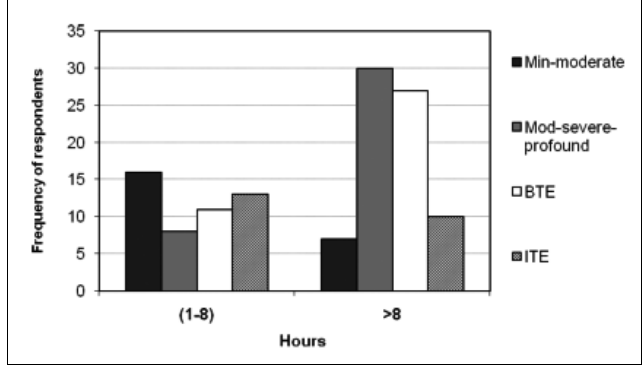
Fig. 2. Degree of hearing loss and type of hearing aid compared with daily use of hearing aid(s) (BTE = behind the ear; ITE = in the